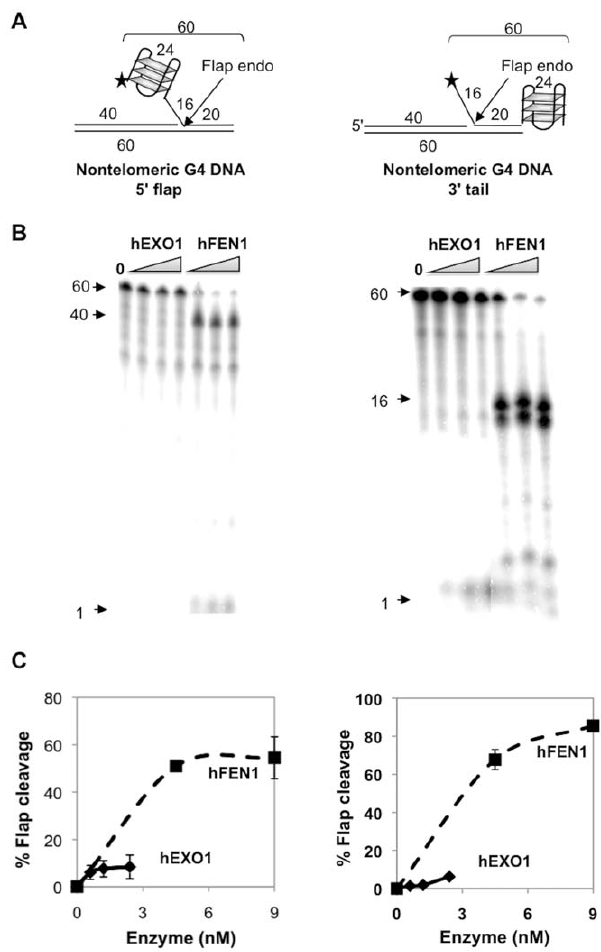
Figure 3. hFEN1, but not hEXO1, cleaves 5 9 nontelomeric G4 DNA flaps and 5 9 flaps adjacent to 3 9 nontelomeric G4 DNA tails. (A) Diagram of substrates bearing 5 9 or 3 9 nontelomeric G4 DNA tails. Lengths of oligonucleotides, flaps, duplex regions and 3 9 tails are indicated; asterisk denotes 5 9 end-label. (B) Products of digestion of substrates shown in Panel A by hEXO1 (0, 1.2, 2.4 and 3.6 nM) and hFEN1 (4.5, 9.0 and 18.0 nM). Arrows indicate 60 nt undigested 5 9 - labeled DNA substrates, products of flap endonuclease digestion, and 1 nt product of exonuclease digestion. (C) Quantitation of flap cleavage activity of hEXO1 (0, 0.6, 1.2 and 2.4 nM; diamonds) and hFEN1 (0, 4.5, and 9.0 nM; squares) on substrates shown in Panel A.